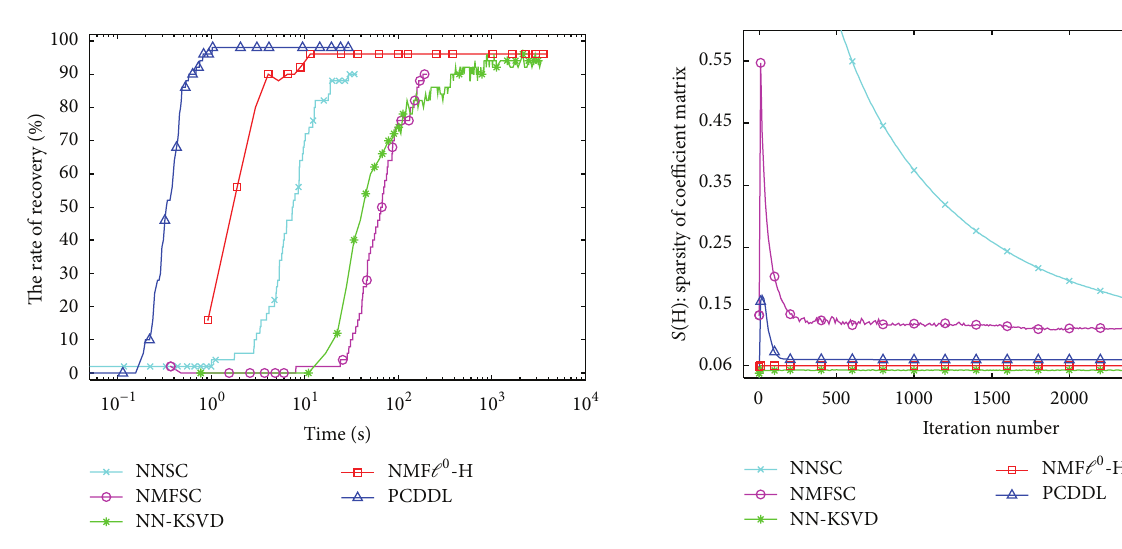
Figure 2: Evolution of the rate of atom recovery versus the runtime of five algorithms. These algorithms run 3000 iterations, respectively. PCDDL achieved the best rate of recovery in the least time.